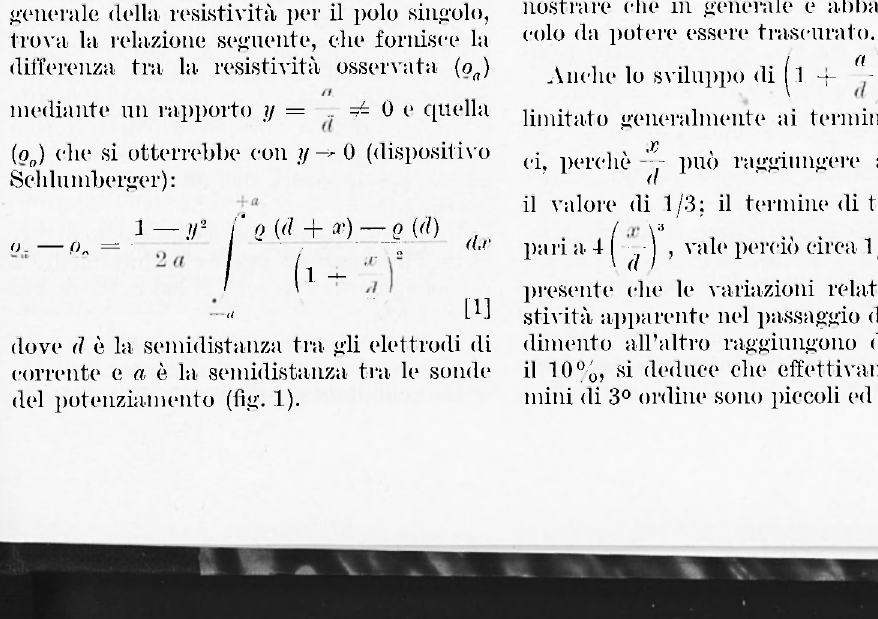
Fig. I 10 sviluppo di o ci limiteremo al termine di terzo grado, poiché è praticamente impos- sibile calcolare le derivate superiori alla se- conda, e l'ultimo termine ci servirà solo a nostrare che in generale è abbastanza pic- colo da potere essere trascurato. Anche lo sviluppo di |l + "-J è